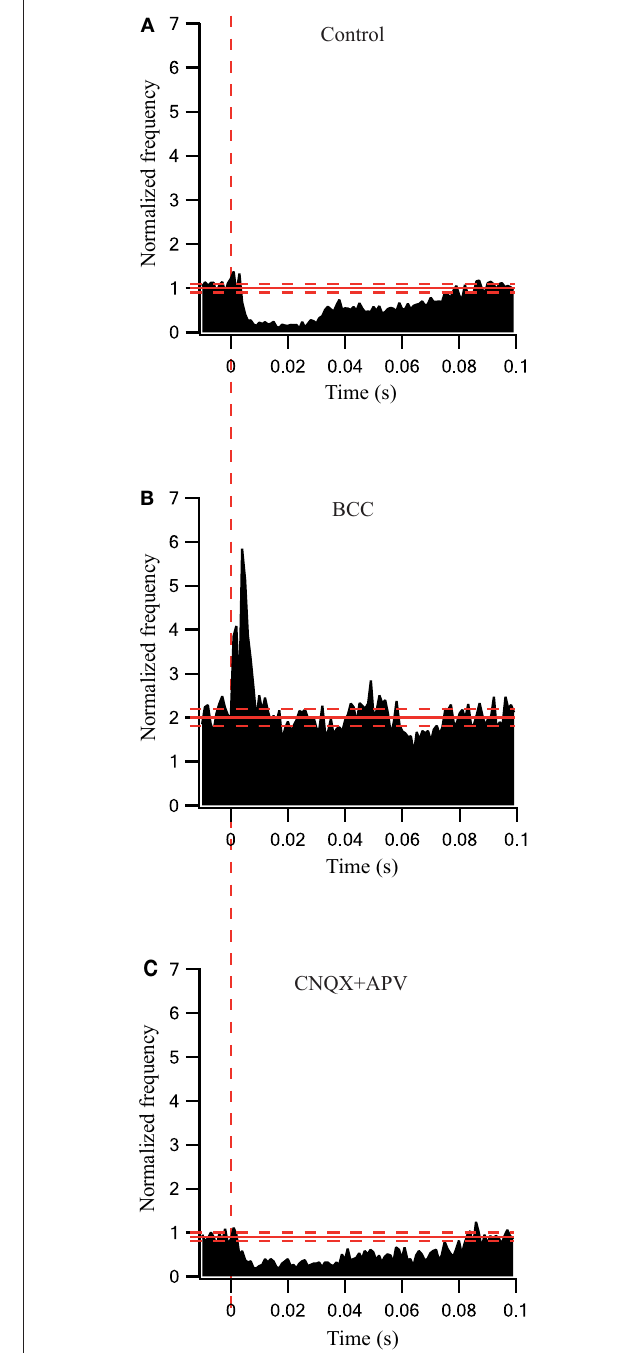
Figure 4 | Synaptically locked response changes during stimulation at 10 Hz before and after application of gABAergic and glutamatergic antagonists. (A) Population PSTH of GP neurons in normal extracellular solution ( n = 38). (B) Population PSTH of GP neurons after applying 50 μM bicuculline to the extracellular solution ( n = 17). (C) Population PSTH of GP neurons after applying 15 μM CNQX and 50 μM APV to the extracellular solution ( n = 14). The thick and dashed horizontal lines indicate the average and SD of pre-stimulus frequency, respectively. The dashed vertical line marks the beginning of the